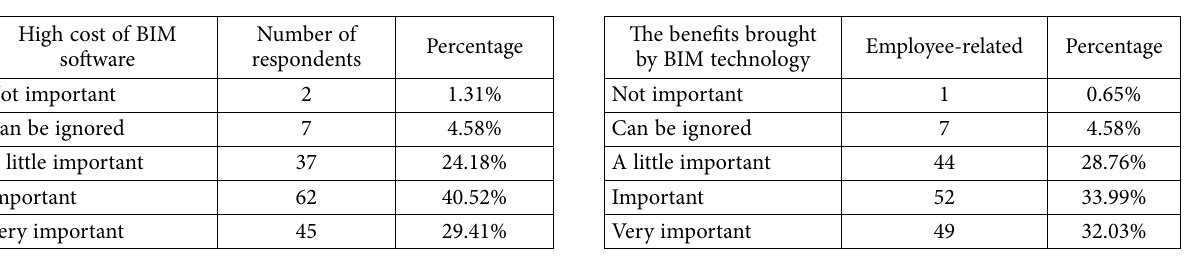
Table 8. Statistics table on the importance of the actual benefits